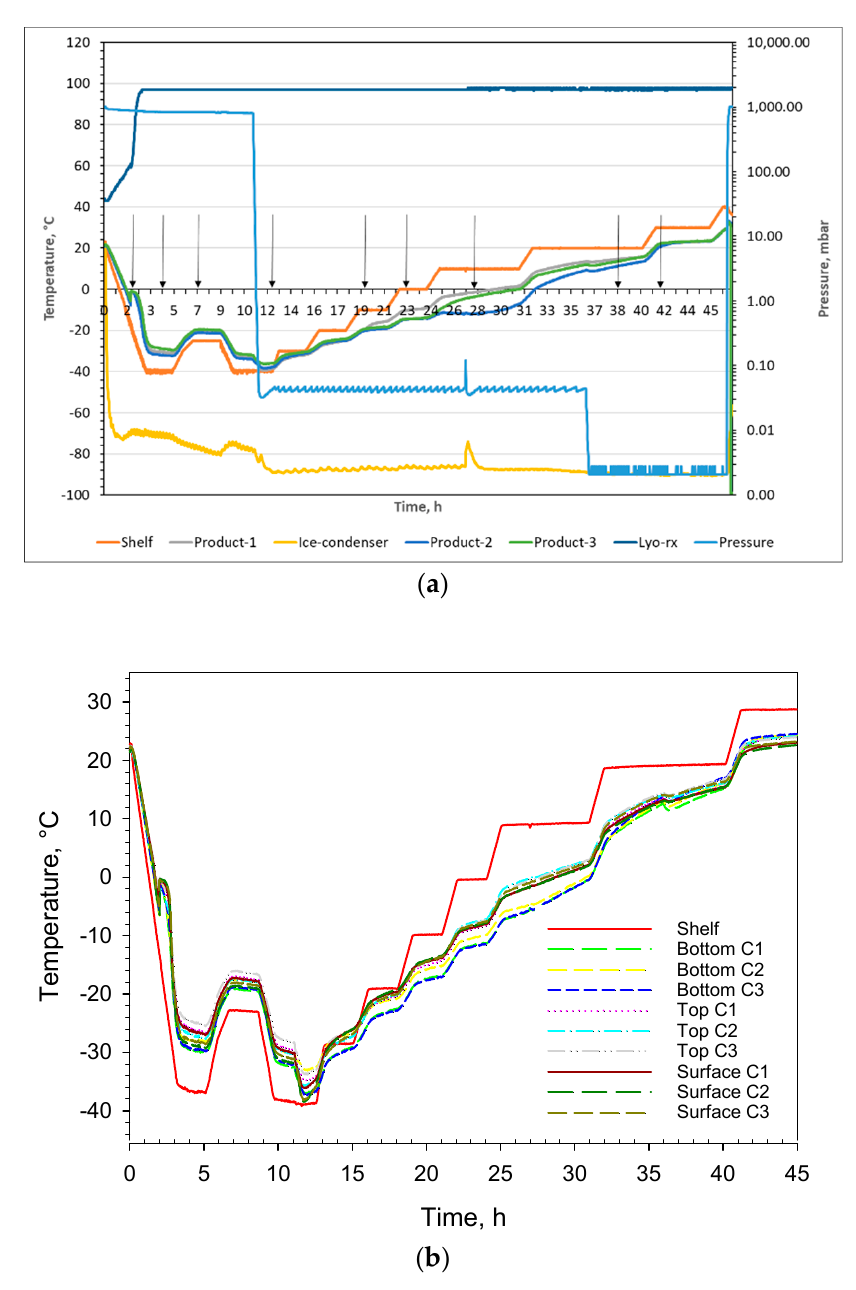
Figure 5. ( a ). Full freeze ‐ drying cycle of the pharmaceutical formulation based on machine readings of product temperature from three Pt ‐ 100 sensors, shelf temperature, pressure, ice ‐ condenser temperature, and resistivity (lyo ‐ RX). Features such as super ‐ cooling, annealing, sublimation, and secondary drying are clearly visible. On top, the lyo ‐ RX value shows 95%, which is indicative of frozen material (no melt) during complete cycle after freezing. Vertical arrows indicate time points of spatial images shown in Figure 8a–i. The read ‐ out values are essentially identical to the set values for pressure and shelf temperature as a function of time. The freeze ‐ drying program can therefore be deduced from ( a ). ( b ). Time profile of the different measurement zones defined in Figure 4b with temperature data taken from 2700 thermograms. Temperature profiles are in close alignment with the temperature read ‐ outs from the freeze dryer shown in ( a ).